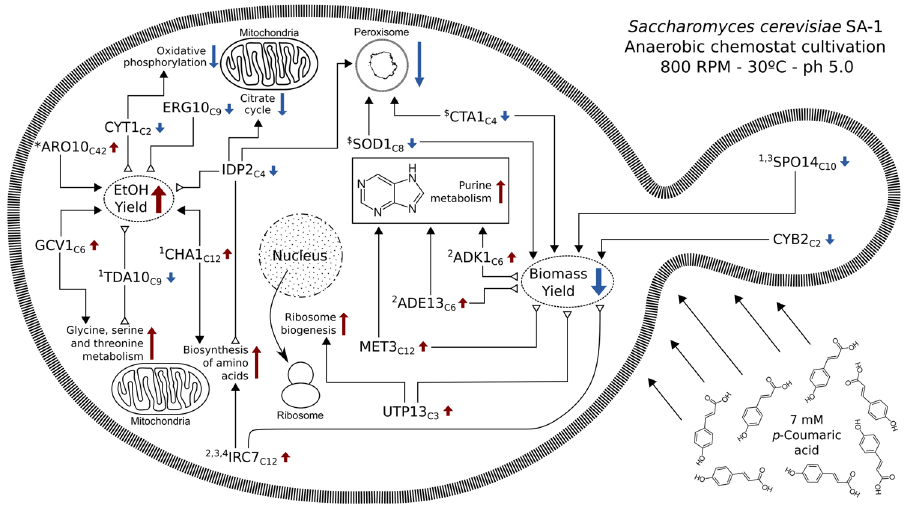
Figure 6. Multi-omics integrated model for alterations induced by pCA stress in the S. cerevisiae SA-1 strain. Network representation of the relation between hub genes, short variants (SVs), perturbed pathways, and phenotypic alterations. Red arrows indicate positive regulation (upregulated genes and pathways), blue arrows show negative relations (downregulated genes and pathways) and black arrows represent additional information sources (presence of SVs or gene ontology categories), with their connector showing the relationship as direct (solid arrowhead, both elements moving in the same direction) or inverted (hollow triangle, elements moving in opposite directions). Genes labeled with numbers indicate the presence of a short variant (1: missense homozygous mutation; 2: missense heterozygous; 3: frameshift heterozygous and 4: stop-gained heterozygous). Genes labeled with symbols represent known associations to either fermentation processes (*) or response to reactive oxygen species